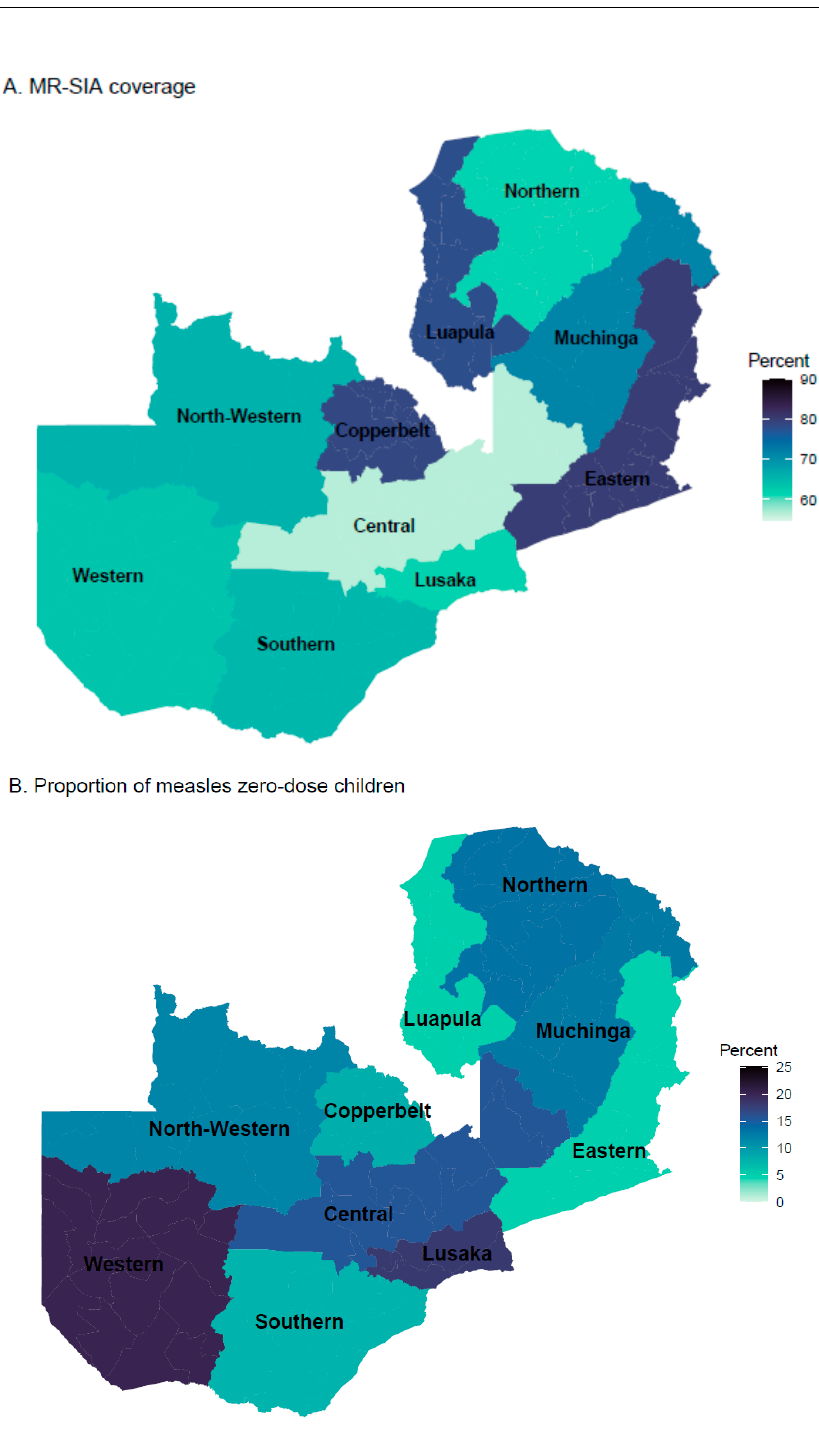
Figure 3. Provincial-level MR-SIA coverage and the proportion of measles zero-dose children. During the SIA, 6.3% (95% CI: 5.6%, 7.1%) of enrolled children received MCV2, and 58.1% (95% CI: 59.8%, 62.8%) received a third or further MCV dose (Figure 4, Table S4). The sensitivity analysis restricted to children who had a vaccination card or other documenta- tion of vaccines (N = 2762) showed that 1.5% (95% CI: 1.0%, 2.0%) of the children received MCV1 through the SIA, 2.7% (95% CI: 2.1%, 3.4%) of children received MCV2, and 3.6% (95% CI: 2.9%, 4.4%) remained measles zero-dose after the SIA (Table